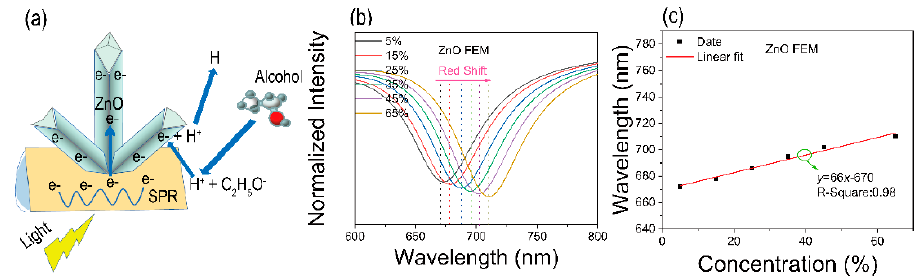
Figure 6. Schematic diagram of the principle. ( a ) Alcohol catalytic mechanism of ZnO nanoflow- ers/Au array structures. ( b ) COMSOL finite element simulation results. ( c ) The sensitivity calculated by COMSOL.